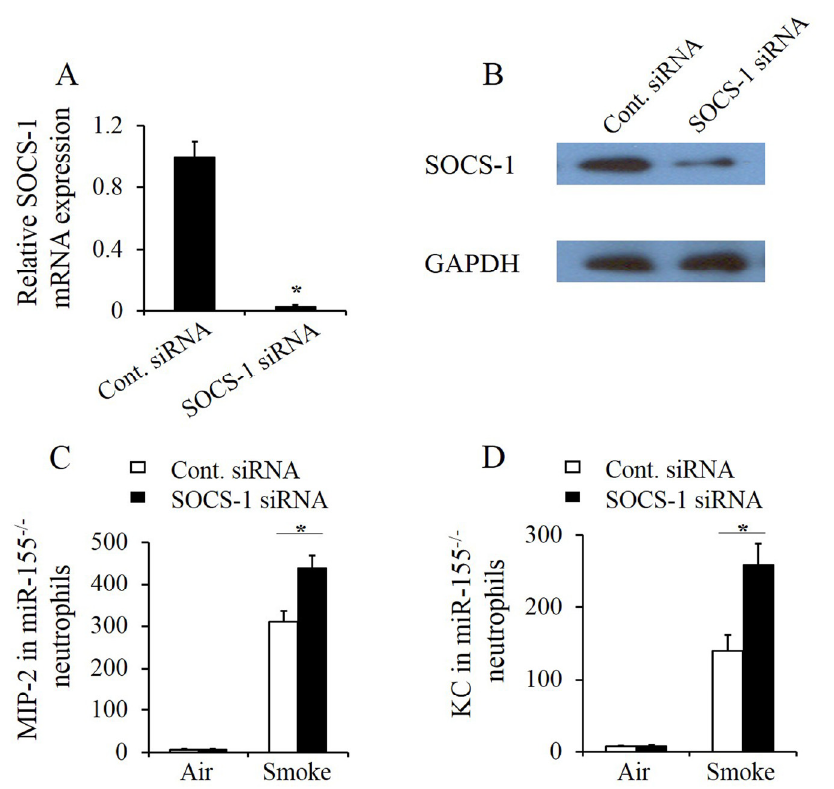
Figure 5. MiR-155 targeted SOCS-1 to regulate inflammatory response in neutrophils. Whole lung neutrophils were isolated from miR-155 – / – mice 12 h after smoke inhalation as described in Section 4, and isolated neutrophils (2 × 10 6 / mL) were transfected with SOCS-1 siRNA or control siRNA. ( A , B ) After 24 h of culture, SOCS-1 mRNA and protein level in neutrophils were measured. n = 4 mice per group. * p < 0.05 vs. neutrophils transfected with control siRNA. Lung neutrophils were isolated from miR-155 – / – mice 12 h after 15 min of smoke inhalation. Isolated neutrophils were transfected with SOCS-1 siRNA or control siRNA. ( C , D ) After 24 h of transfected cell culture following smoke treatment of 30 min, the supernatant medium was collected and used to measure MIP-2 and KC protein by ELISA 24 h after smoke exposure. n = 4 mice per group. * p < 0.05.